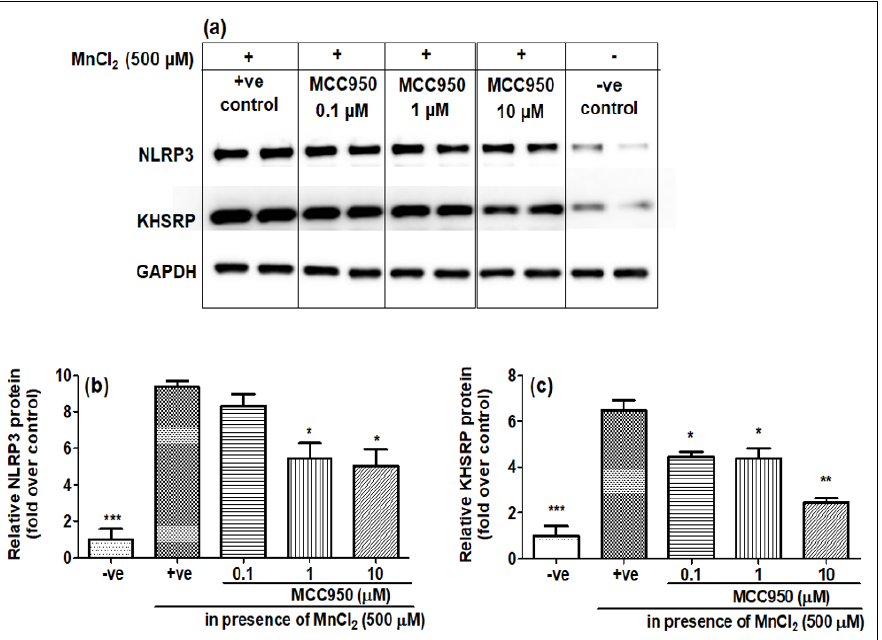
Figure 5. MCC950 inhibited the MnCl 2 -induced KHSRP and NLRP3 protein levels in a dose-de- pendent manner. N2a cells were pre-treated for 1 h with MCC950 (0.1, 1 and 10 µM) and later ex- posed to MnCl 2 (500 µM) for 24 h. ( a ) Western blot images for NLRP3, KHSRP and GAPDH, ( b ) histograms for KHSRP relative protein levels, ( c ) histograms for NLRP3 relative protein levels. All protein values were normalized to the housekeeping protein, GAPDH, and expressed as a fold- induction over the control sample (set at a value of 1). Data represented as mean ± SEM. * p < 0.05, ** p < 0.001, *** p < 0.0001 vs. control group.